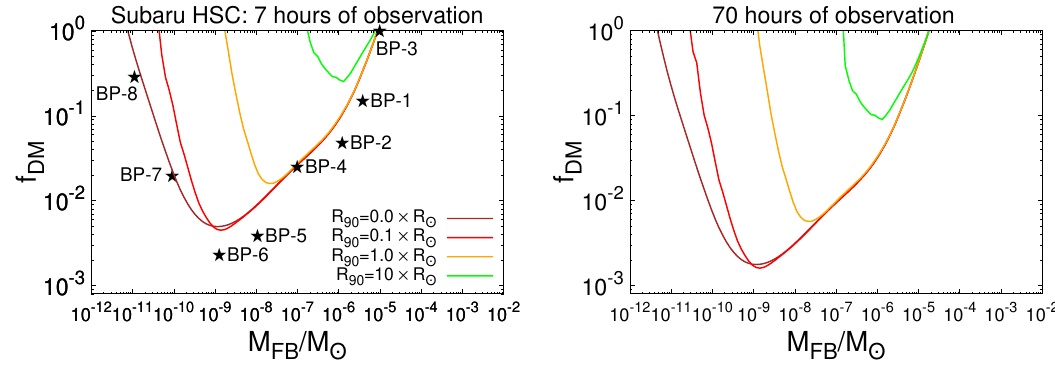
Figure 5 . Left-panel: current 95% C.L. upper limits on the FB fraction of dark matter from the Subaru-HSC survey of M31. The benchmark points in table 1 are marked with stars. Right-panel: expected sensitivity of Subaru-HSC with 10 times the observation